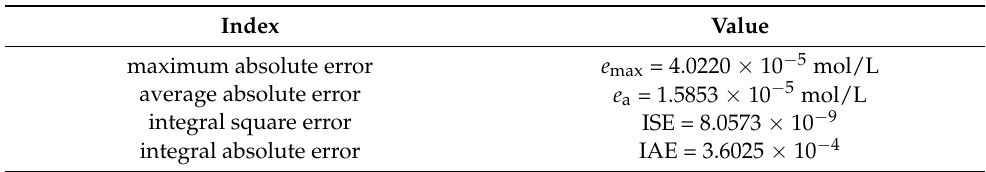
Table 4. Quantitative assessment of the accuracy of the identified temperature-dependent model (deviation between simulated and measured